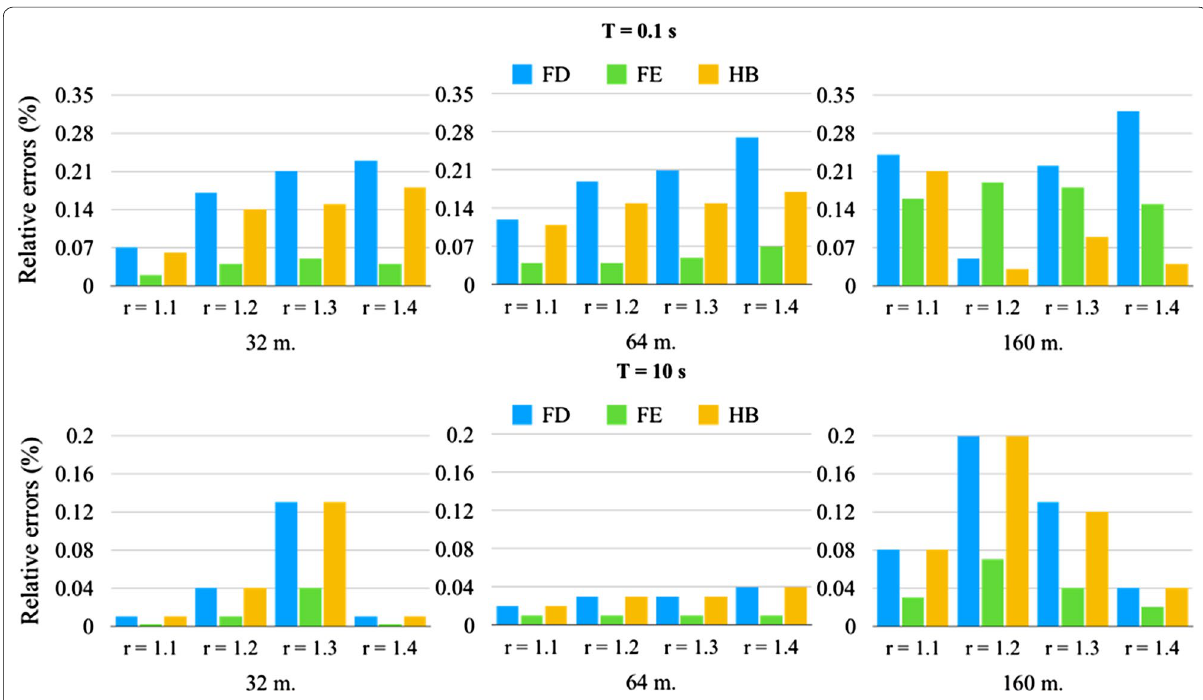
Fig. 7 Relative errors (%) of phases calculated at T = 0.1 (top) and 10 s (bottom) for the two-layered model